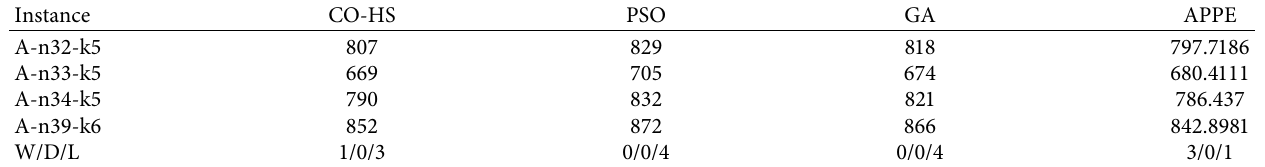
Table 17: Comparison of the best result of 20 runs of APPE with the algorithms in Yan et al.